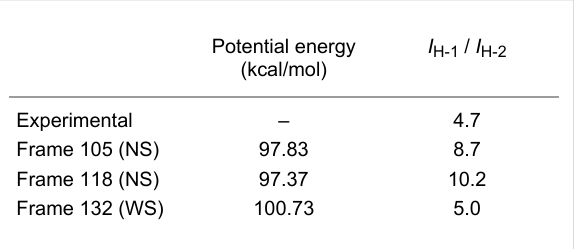
Table 1: Peak intensity ratios calculated from ROESY spectrum (experimental) and from conformations obtained by molecular dynamics